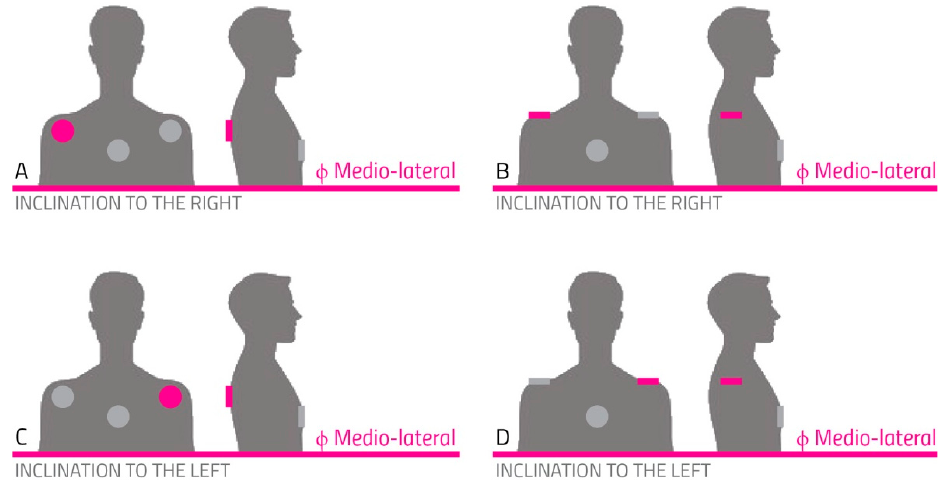
Figure 4. Actuator positioning for the correction of mediolateral inclination.